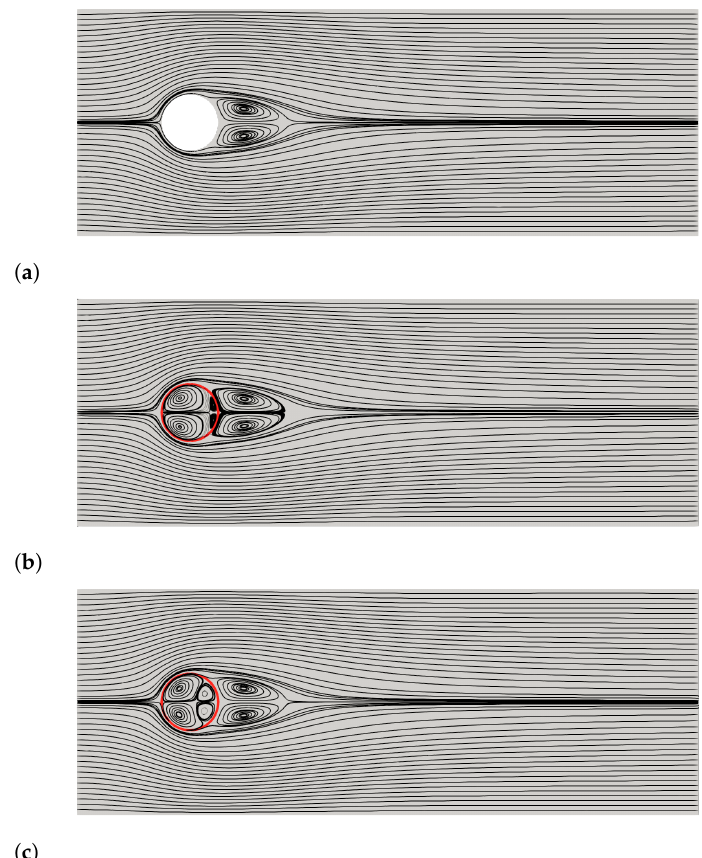
Figure 6. The streamlines of the solutions obtained by using ( a ) Fluent, ( b ) mesh-based IB method and ( c ) IB-PINN.